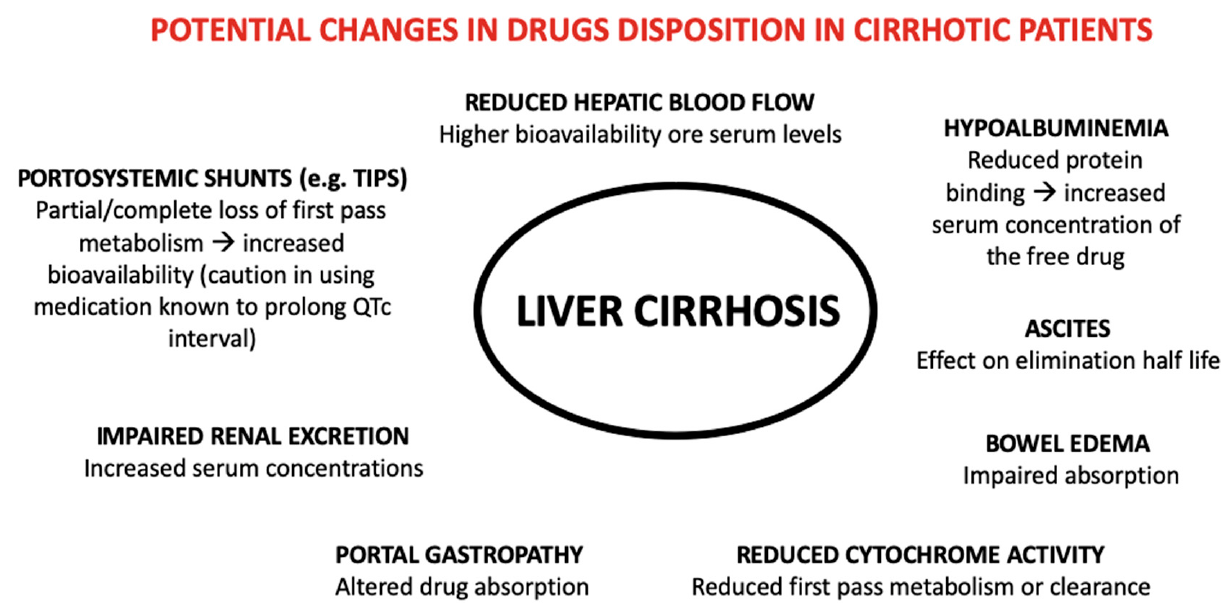
Figure 1. Potential changes in drug disposition in cirrhotic patients.